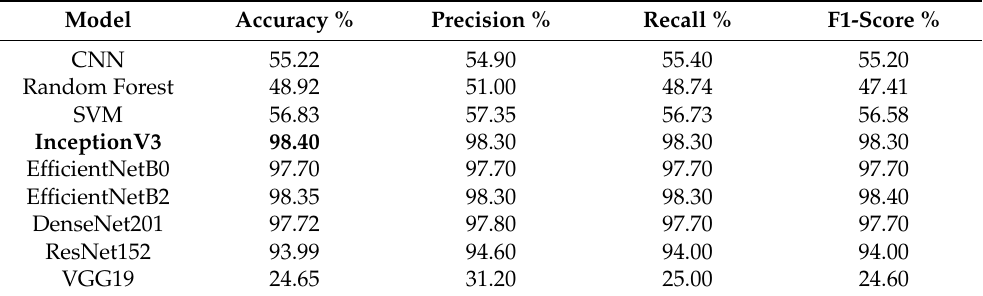
Table 5. Performance analysis of explored models for facemask coverage classification.